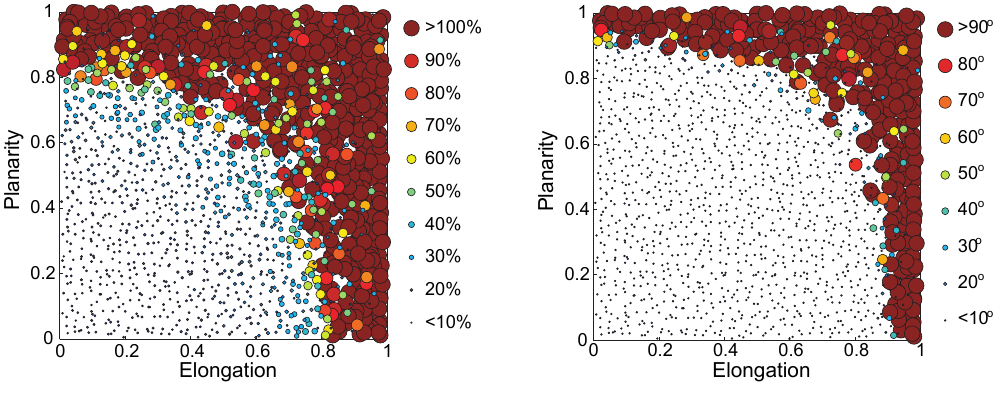
Fig. 2. Same format as in Fig. 1, but the modeled discontinuity speed is 1/10 of the Cluster